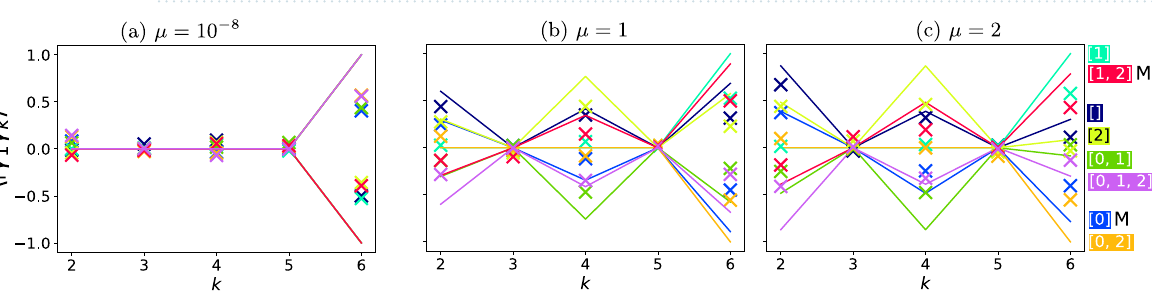
Figure 4. Site correlation function where k denotes the site at different values of the chemical potential in the topological regime (cid:31) = − t = 1 . Full lines denote values obtained by an ideal simulator of quantum computers at points of integer k and “x”-markers are output from IBMQ Santiago. Colour code is explained on the